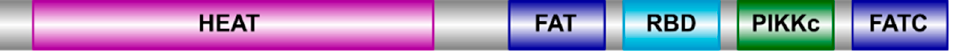
Figure 1. Schematic representation of the canonical domain organization of TOR proteins. HEAT repeats (purple), FAT (dark blue), RBD (light blue), PIKKc (green), and FATC (dark blue). Drawing generated with the IBS program [23].